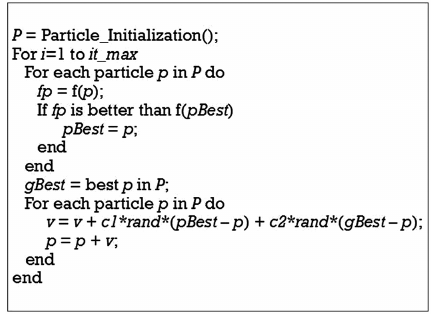
Figure 1. The PSO Algorithm